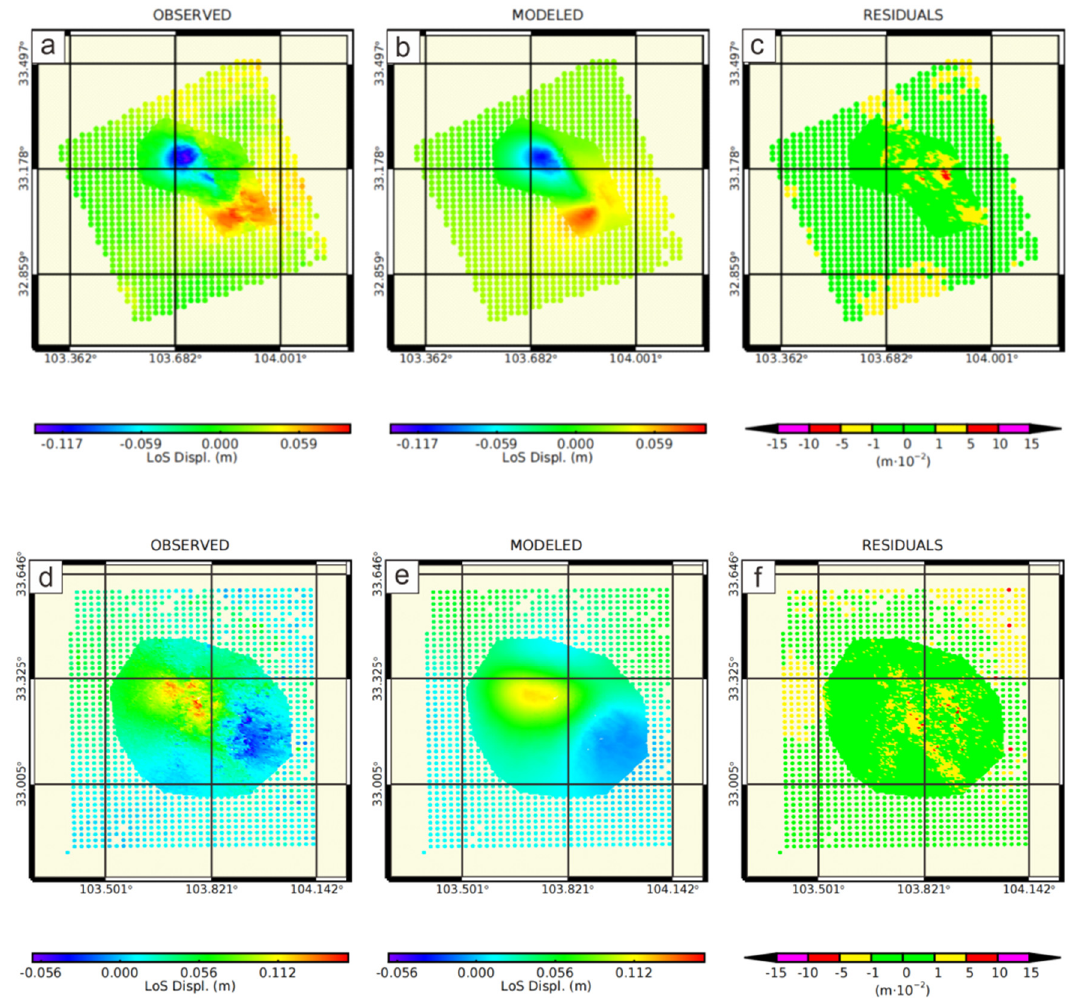
Figure 14. Observed, modeled deformation field and residuals inverted from InSAR data: Panels ( a ) and ( b ) are observed and modeled ascending InSAR deformation fields; ( c ) is the residuals to the observed deformation field; ( d ) and ( e ) are observed and modeled descending InSAR deformation fields; ( f ) is the residuals to the observed deformation field.